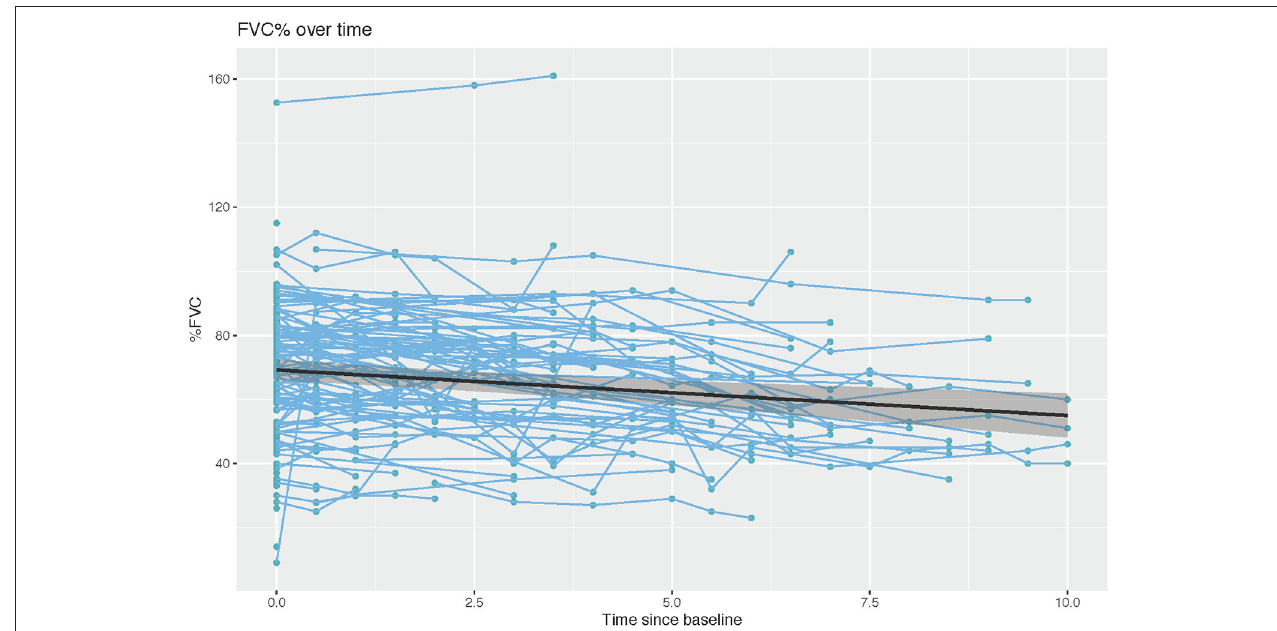
FIGURE 2 | Rate of change in percent predicted FVC over time ( r = − 1.421, Wald statistic = 13.92 [ p < 0.001], n = 152 subjects with 522 observations).